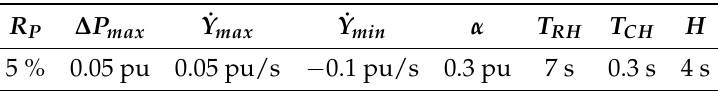
Table 1. Parameters for the conventional generator